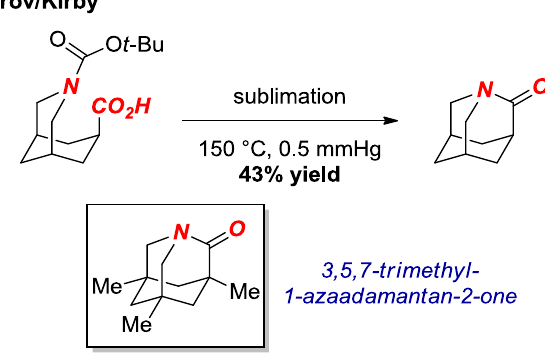
Figure 7. Synthesis of Parent 1-Azaadamantan-2-one.